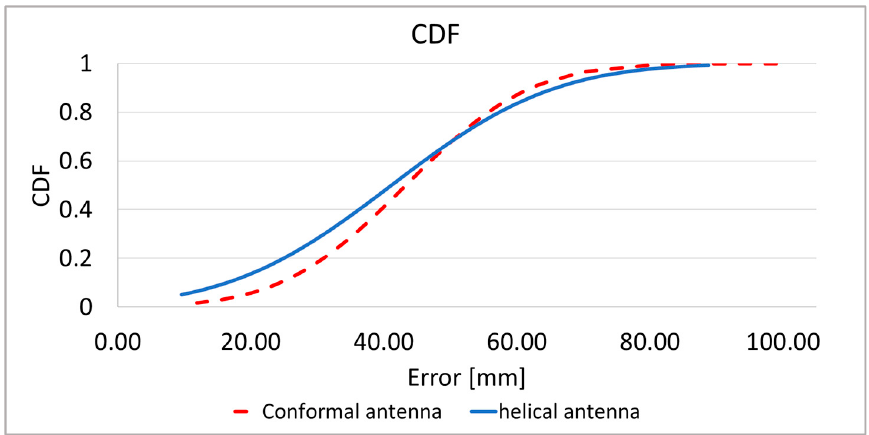
Figure 18. Cumulative distribution function (CDF): error comparison for helical and proposed conformal antenna with adaptive A and B receivers selection. Results for 160 capsule positions in the digestive tract.